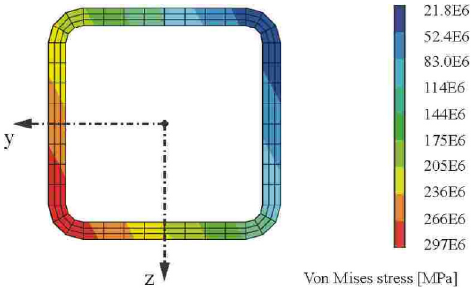
Fig. 3. Example of the von Mises stress state of